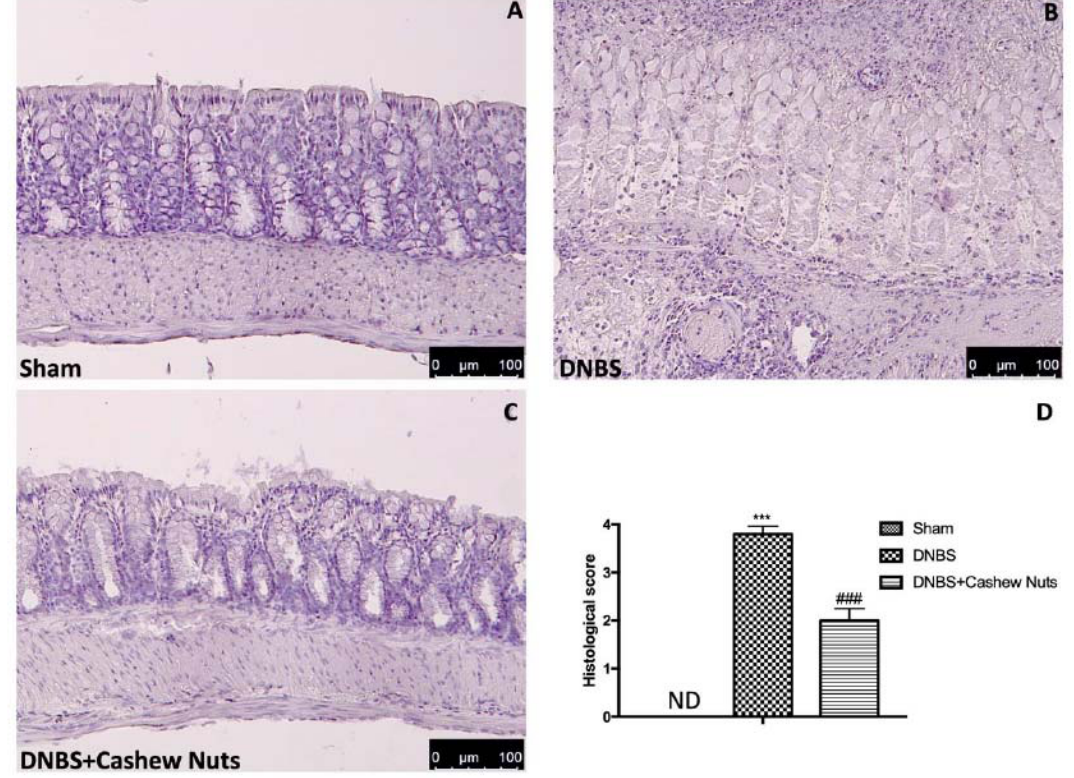
Figure 3. The e ff ects of cashew nuts on histological damage after DNBS injection. Histological analysis was evaluated in sham ( A ), DNBS ( B ), DNBS + cashew nuts ( C ). Histological score was measured ( D ). Images are figurative of at least three independent experiments. Values = means ± SEM of six animals in each group; *** p < 0.001 vs. sham; ### p < 0.001 vs.